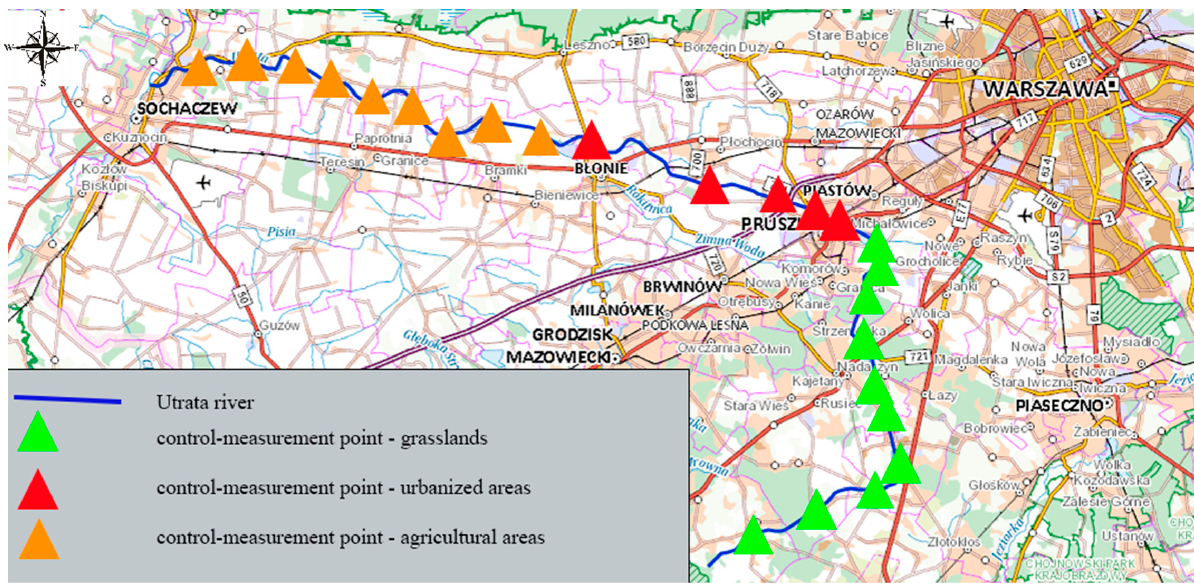
Figure 2. Study area—locations of control-measurement points on the Utrata river; https://mapy.geoportal.gov.pl/imap/Imgp_2.html?gpmap=gp0 (accessed on 1 August 2021).